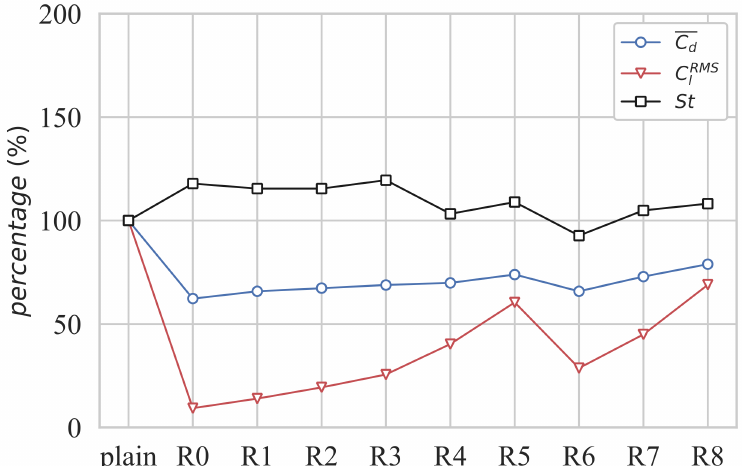
Figure 10. Comparisons of RMS lift coefficients, mean drag coefficients, and Strouhal number for the nine rotating cases and the plain cylinder.